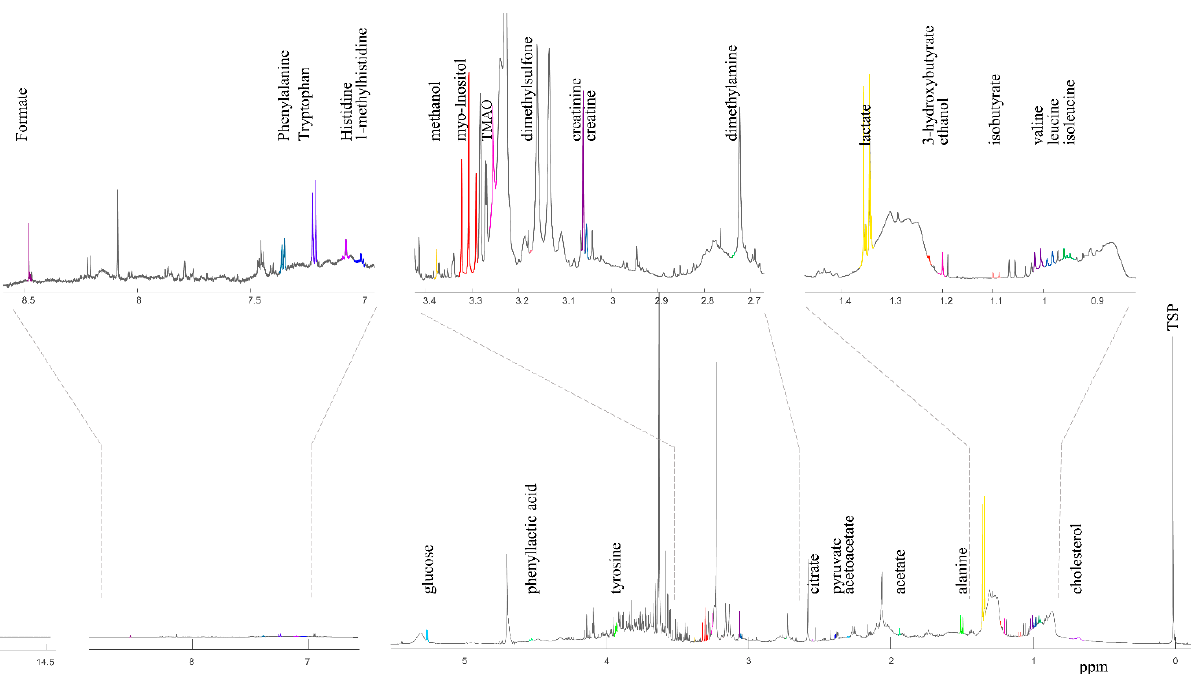
Figure 1. A representative one-dimensional proton ( 1 H) NMR spectrum of pig blood plasma sample and SigMa-identified signature signals of selected blood metabolites. Intensity is scaled to the maximum of 2.5 × 10 7 .